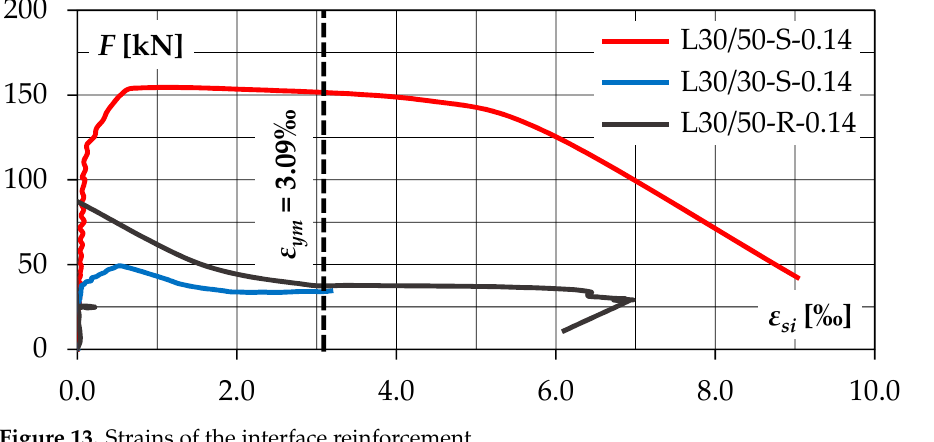
Figure 13. Strains of the interface reinforcement. Table 9. Steel strain and stress at peak load.